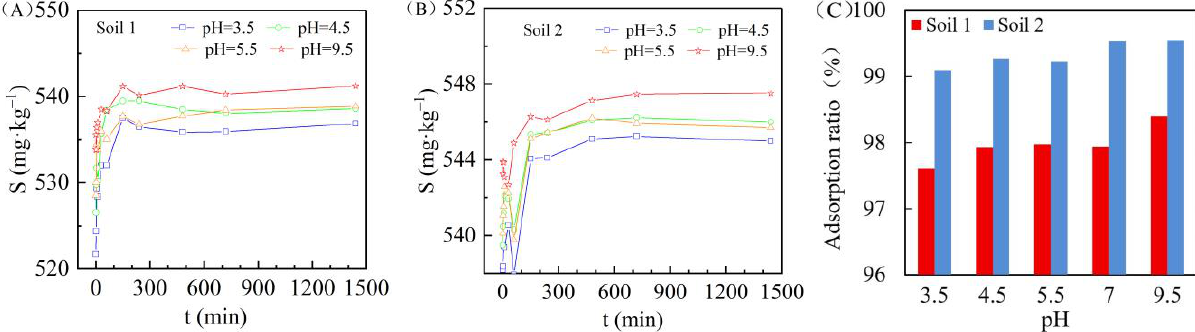
Figure 7. Relationship between oscillation time and cadmium adsorption capacity in soil 1 ( A ) and soil 2 ( B ) under different pH values, and adsorption ratio under different pH values in different soils ( C ). Table 3. Dynamic fitting of the exponential asymptote equation for the two soils under different solution pH values.